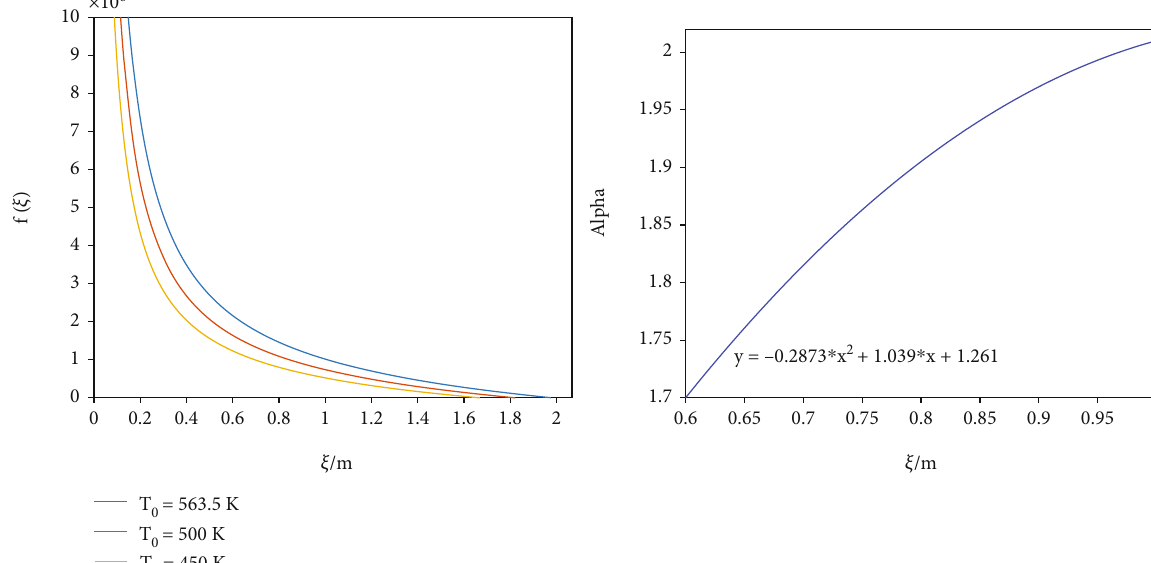
Figure 6: The variation of the decomposition front with the initial temperature and fractional